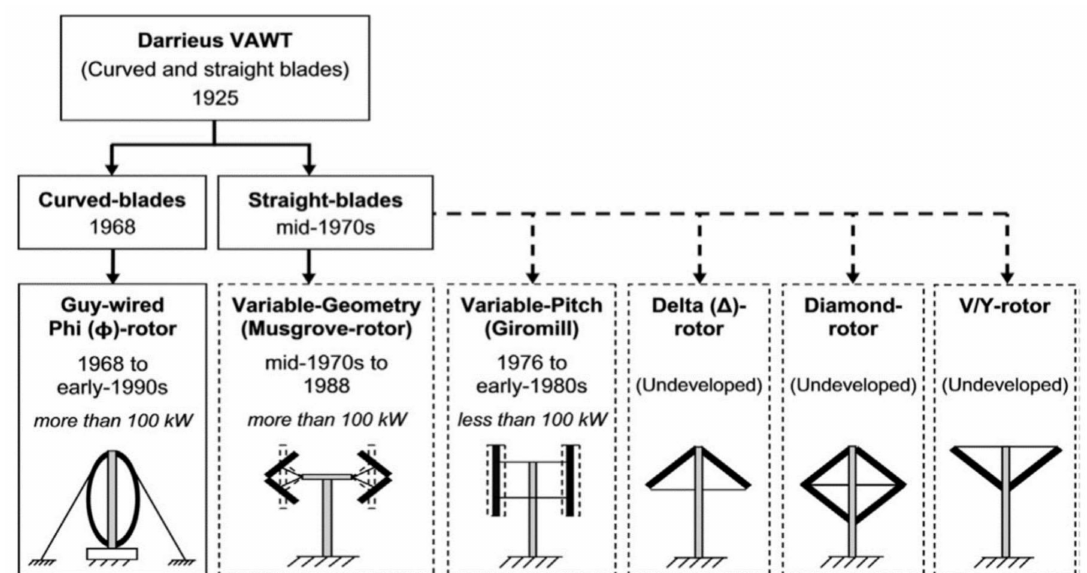
Figure 12. Historical timeline of the Darrieus wind turbine